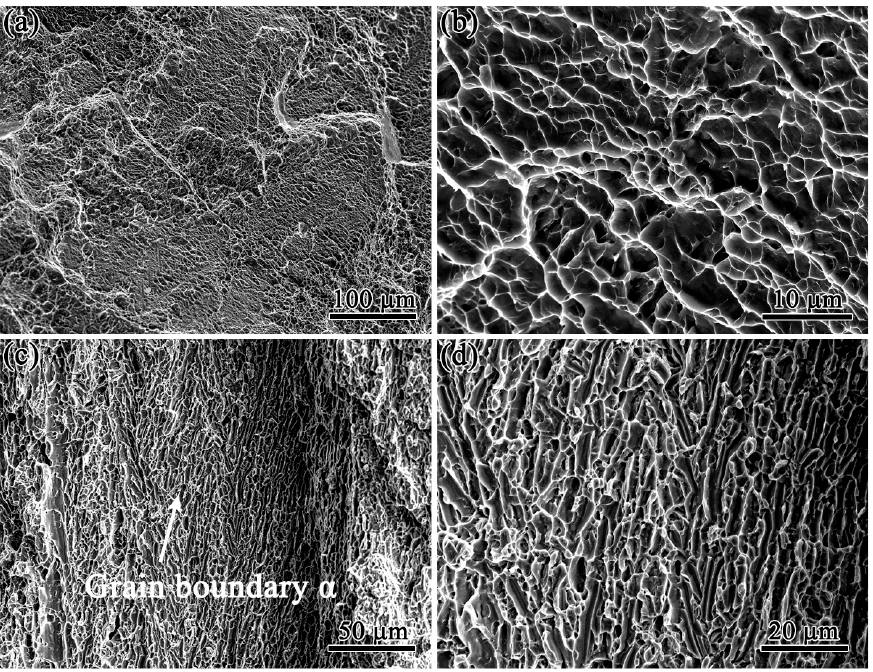
Figure 9. Fracture morphology of the fatigue-damaged samples after 30,000 pre-cycles: ( a ) Low- power and ( b ) high-magnification images of the H-charged sample. ( c ) Low-power and ( d ) high- magnification images of uncharged samples.